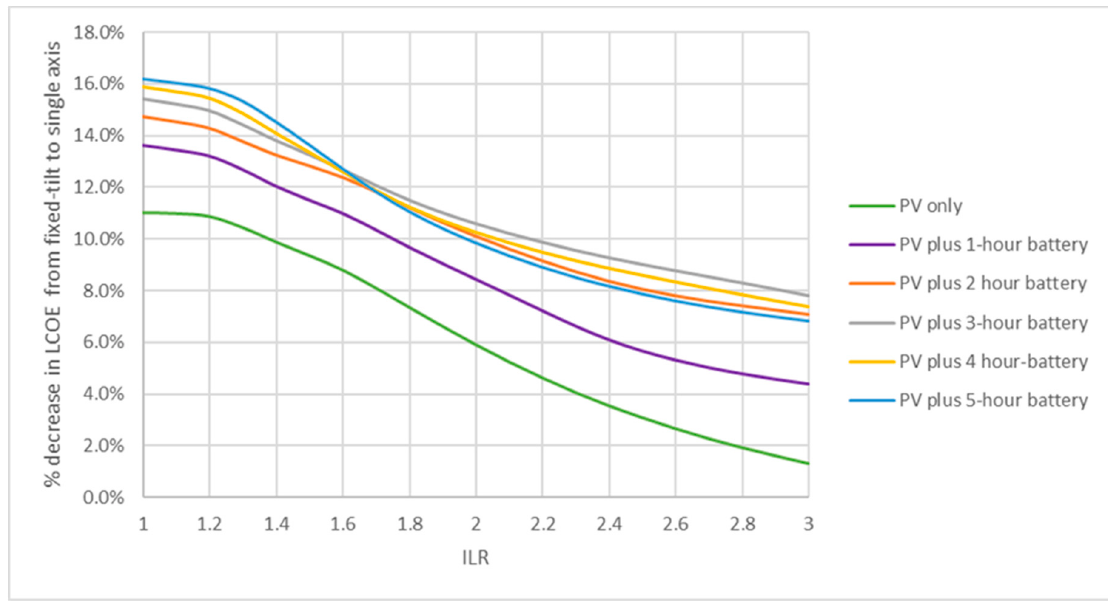
Figure 11. Percentage decrease in LCOE brought by single axis tracking over fixed tilt.